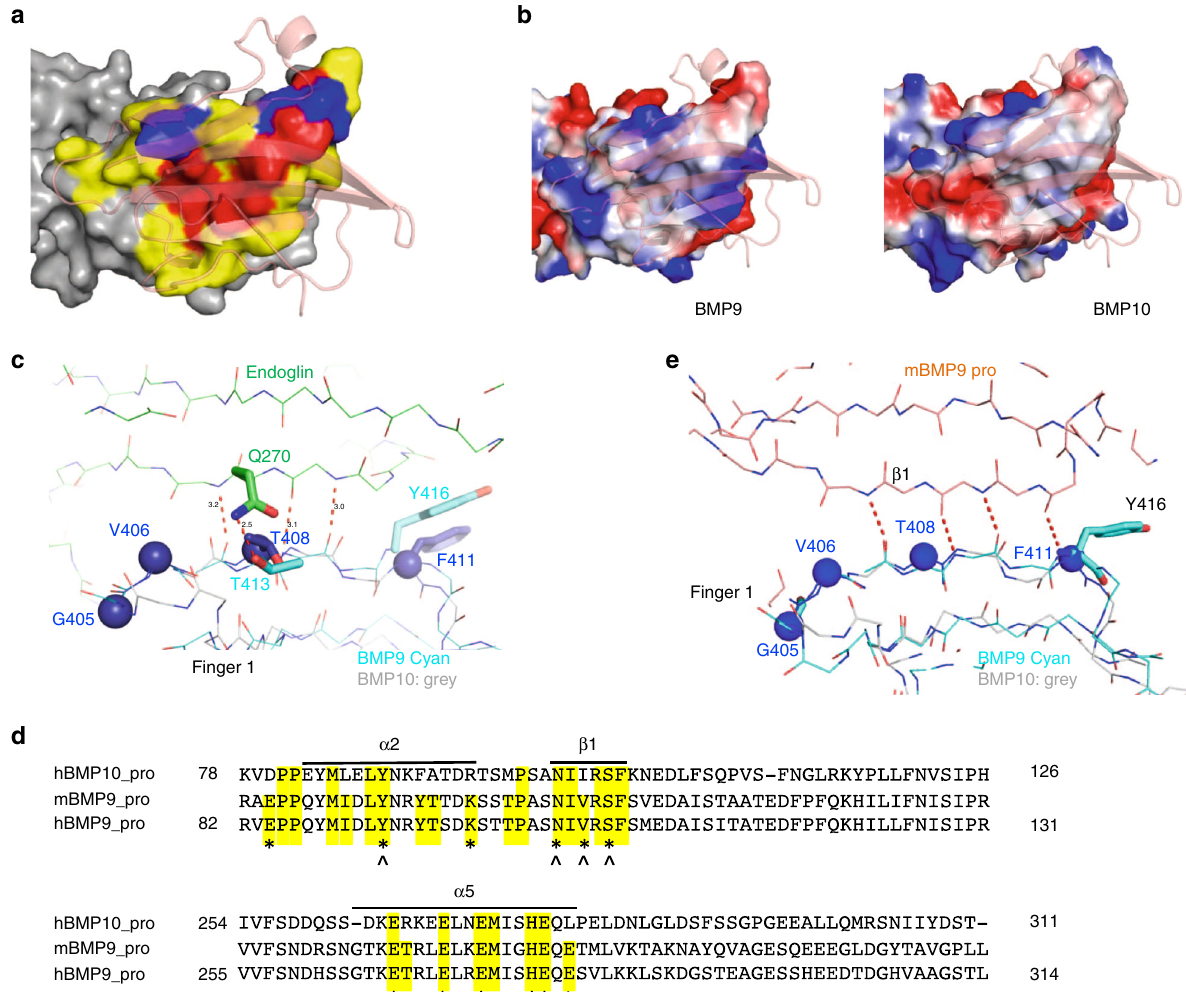
Fig. 5 Conserved region 2 and type II site analysis. a ActRIIb-binding residues (based on PDB:4FAO, ActRIIb in semi-transparent cartoon) are mapped onto BMP9 surface (grey), with those conserved across all BMPs in Fig. 3a coloured in red, those from conserved region 2 in blue, and other variable residues in yellow. b Type II binding surface of BMP9 (left) and BMP10 (right), showing as electrostatic surface (generated in PyMOL, red representing negatively charged and blue positively charged surface). ActRIIb is shown in orange, semi-transparent cartoon. c Residues from BMP9 conserved region 2 make three backbone β -sheet and one sidechain H-bond interactions with ENG (PDB:5HZW, ENG in green, BMP9 in cyan). BMP10 is overlaid onto BMP9 and shown in grey, with four conserved region 2 residues shown in blue spheres. Sidechains of other residues are omitted for clarity. d Sequence alignment of human BMP10 prodomain (hBMP10_pro) with mouse BMP9 prodomain (mBMP9_pro) and human BMP9 prodomain (hBMP9_pro). Residues at the BMP9-binding surface are highlighted in yellow and those that make direct interactions with BMP9 GF-domain are marked with *. Residues that make main chain interactions are also marked with ^. Only the prodomain regions that interact with BMP9 GF-domain are shown, and full-length alignment of hBMP9_pro and hBMP10_pro can be found in Supplementary Fig. 5. e Residues in conserved region 2 of BMP9 make four backbone H-bond β -sheet interactions with prodomain (PDB:4YCG; prodomain in orange, BMP9 in cyan. BMP10 is overlaid on BMP9 and shown in grey. Four conserved BMP10 residues are in blue